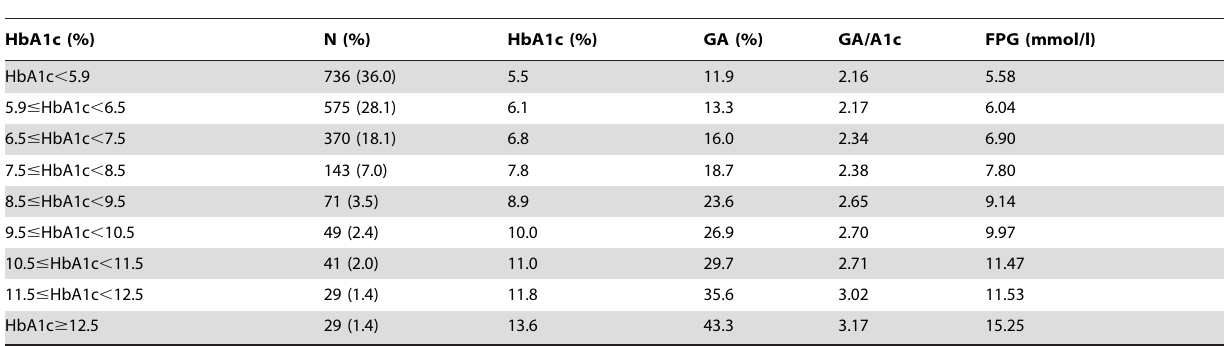
Table 3. Mean values of glycemic parameters according to HbA1c.